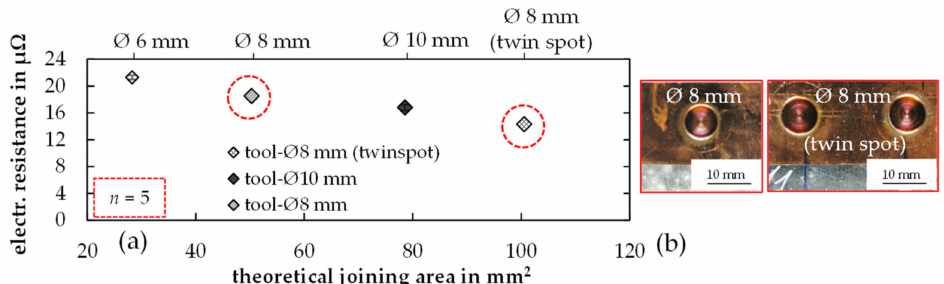
Figure 20. Effects of tool diameter downscaling on electrical properties ( a ) and sample with an 8 mm diameter spot and twin spot ( b ) exemplary. Increase of electrical resistance—i.e., decrease of electrical performance while scaling down the tool diameter—best electrical joint performance with twin